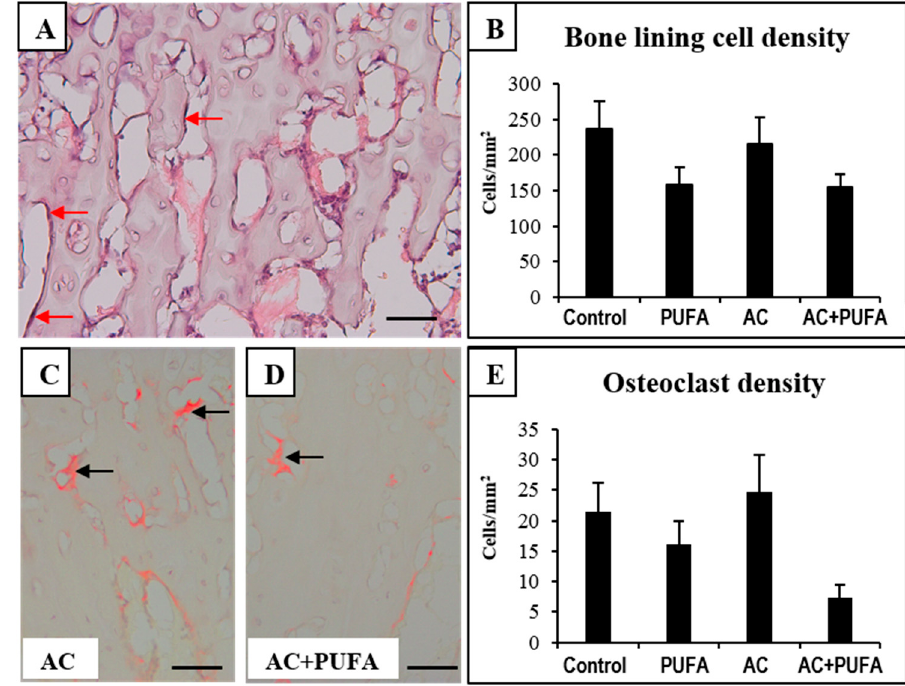
Figure 4. Effects of daily omega-3 polyunsaturated fatty acid (3PUFA) supplementation during weekly AC treatment on bone cells at primary spongiosa. H&E stained metaphysis of a control rat ( A ); with arrows pointing to bone lining cells. Analyses of the treatment effects on bone lining cell density ( B ); Tartrate-resistant acid phosphatase (TRAP)-stained tibia sections of an AC-treated rat ( C ) and AC + PUFA-treated rat ( D ); with arrows pointing to multinucleated osteoclasts. Treatment effects on osteoclast density ( E ). Scale bar on all panels A, C and D = 50 µm.